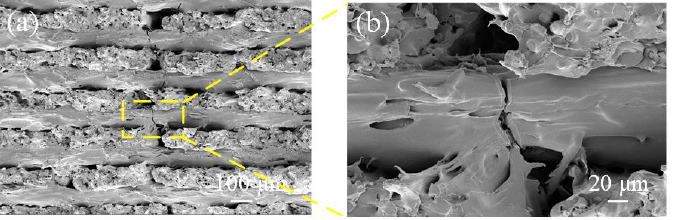
Figure 11. SEM micrographs of the tensile sample without fiber. ( a ) whole section, ( b ) single layer section.